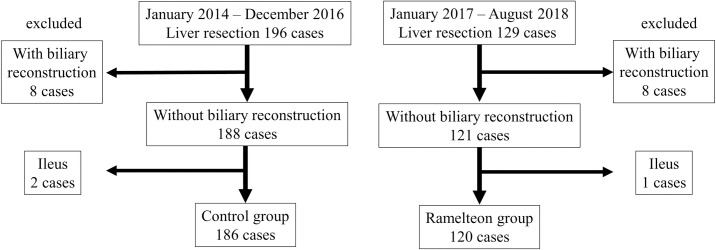
A flow chart of the eligible/included patients is shown.